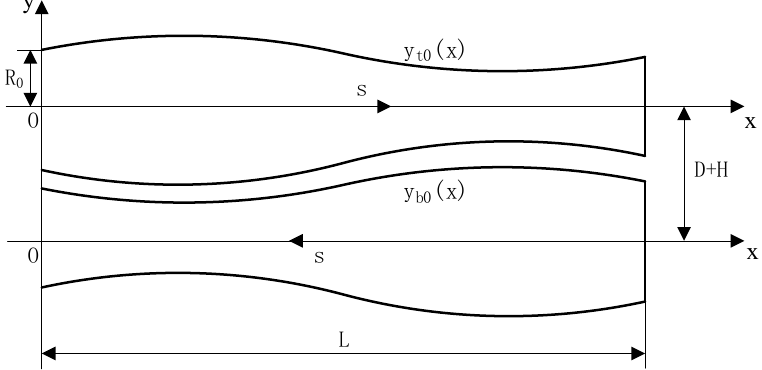
Figure 2. Curve of CVC, data from [29].